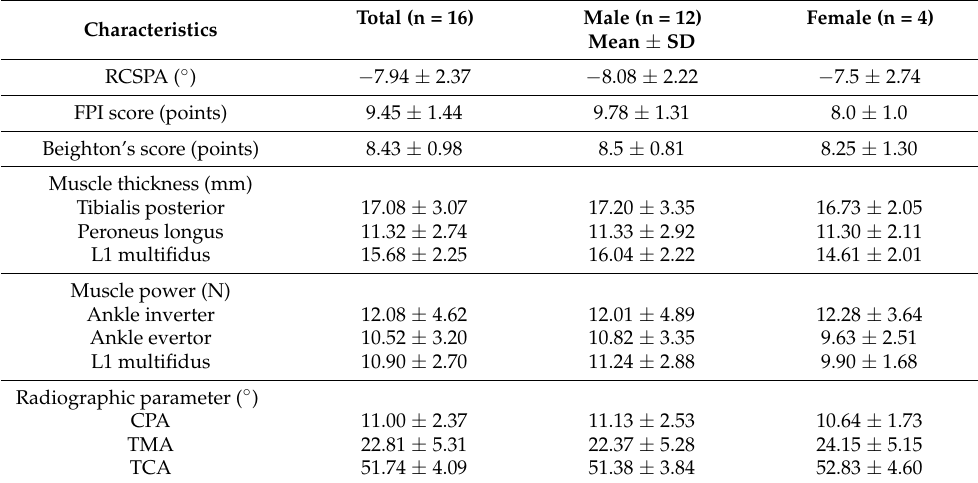
Table 3. Clinical parameters and values of radiologic and ultrasonographic measurements according to the